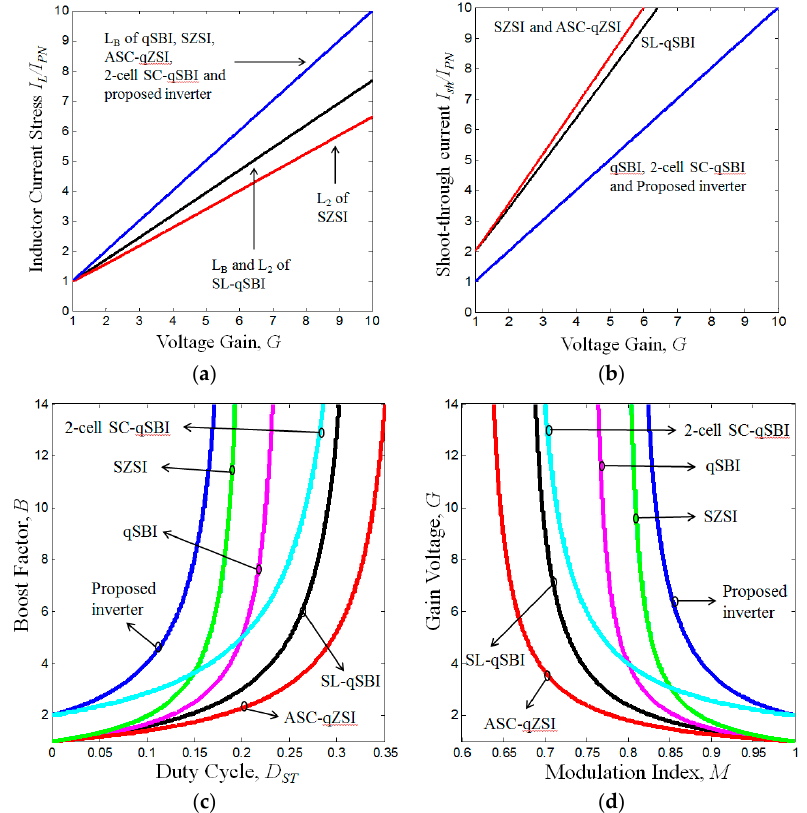
Figure 5. Voltage and current stress comparison. ( a ) Inductor current stress, ( b ) ST current stress, ( c ) boost factor, and ( d ) voltage gain.